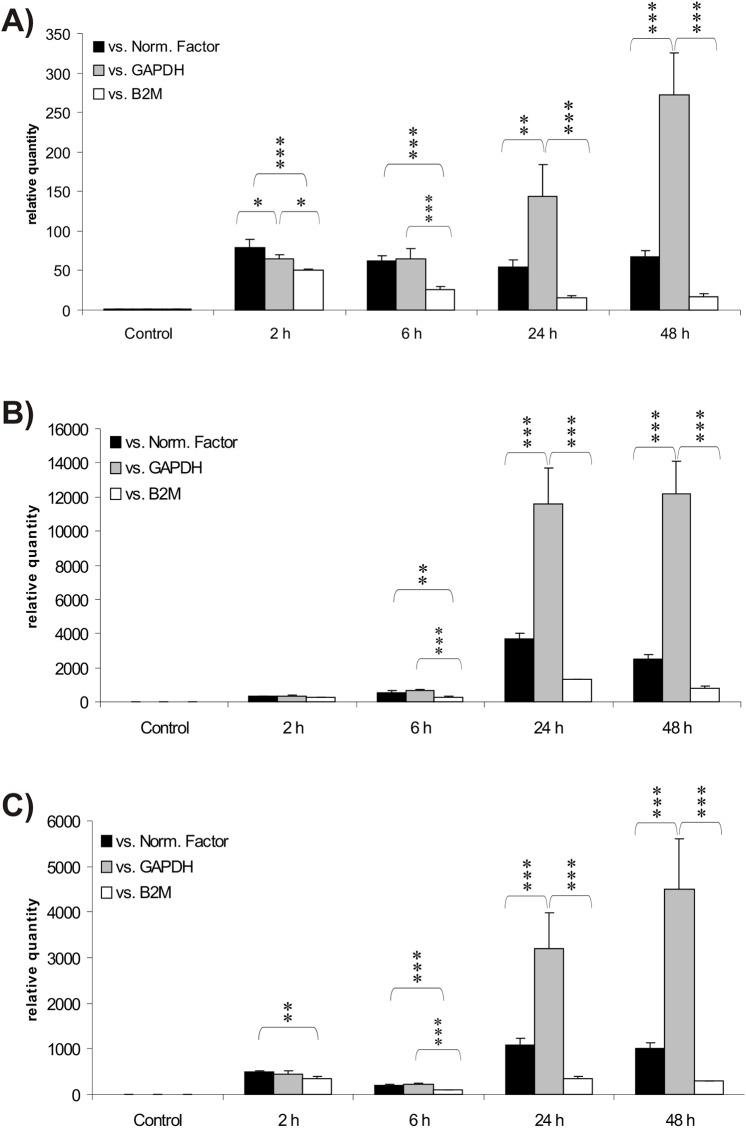
TNF-α induces the expression of inflammation markers in blood-brain barrier endothelial cells.Expression levels of ICAM1 (Panel A), VCAM1 (Panel B) and MCP1 (Panel C) were monitored by qRT-PCR prior (control) and 2 to 48 hours following TNF-α treatment. Expression levels were normalized against PSMB6 / HPRT1 as a reference geneset (Normalization Factor; black graphs), or against single genes, here GAPDH (grey graphs) or B2M (white graphs). Results are presented as arithmetic means ± standard deviations. Statistical significance: * signifies p < 0.05, ** p < 0.01, and *** p < 0.001; lack of asterisks denotes lack of a statistically significant difference.